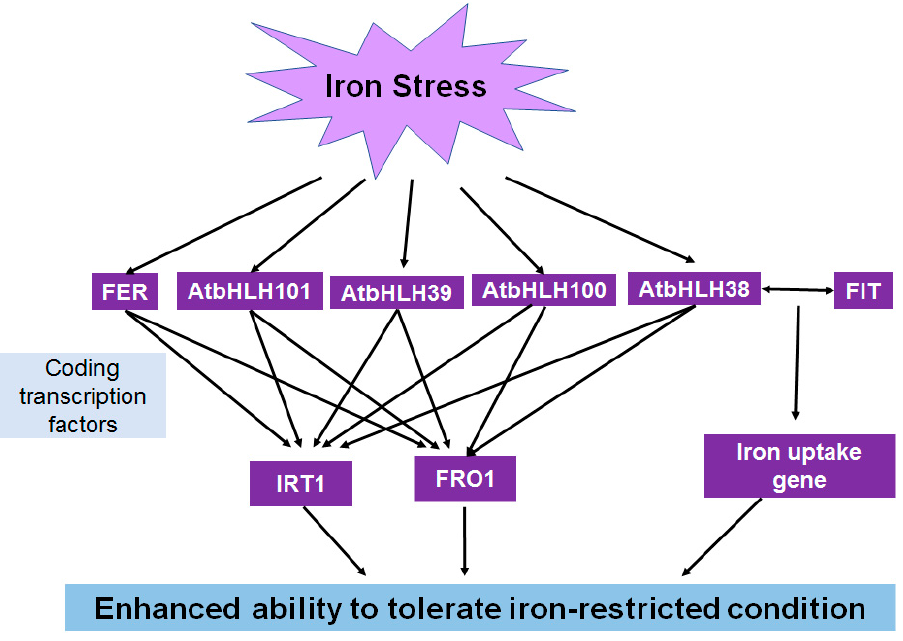
Figure 4. Model of the roles of bHLHs in iron stress tolerance. Additionally, the functions of various investigated bHLH genes in plants related to abiotic stresses have been summarized and shown in Table 1. Table 1. Studied basic helix-loop-helix ( bHLH ) genes that are involved in abiotic stress response in